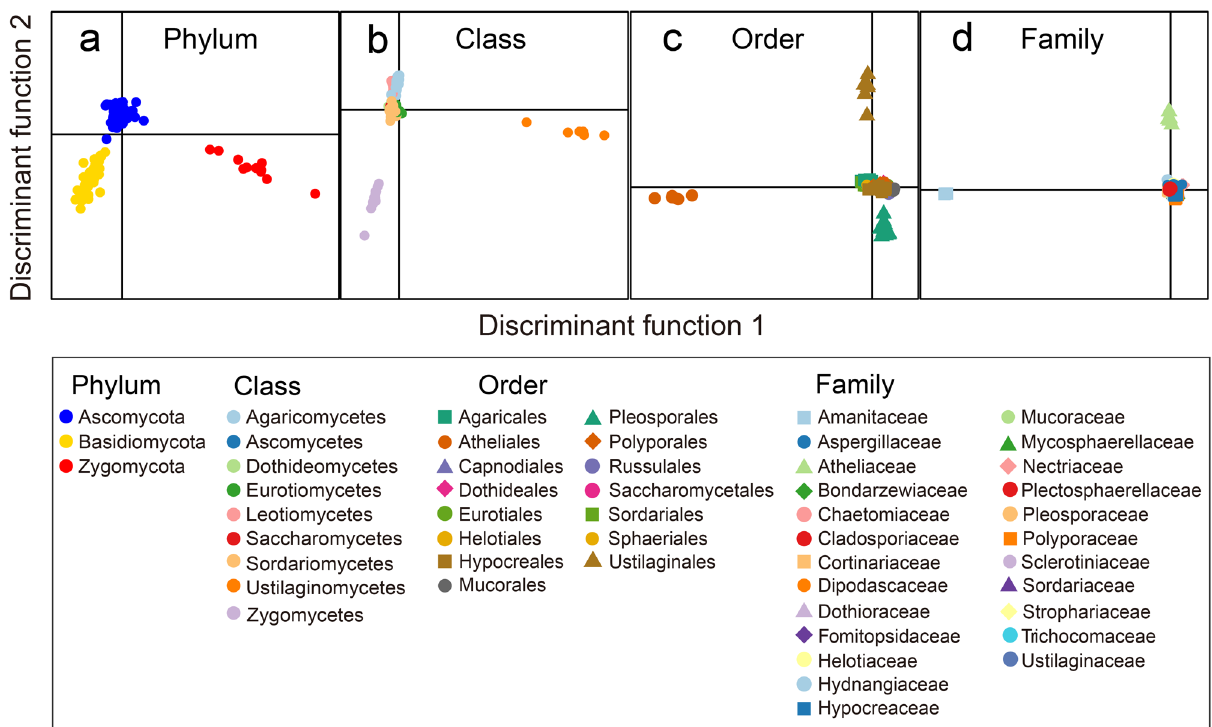
Fig. 3 Chemotaxonomic characterization of different fungal clades. The chemotaxonomic characterization comprises phylum ( a ), class ( b ), order ( c ), and family ( d ) by discriminant analysis of principal components (DAPC) using combined PTR-ToF-MS and GC – MS data. Detailed parametric con fi gurations of DAPC models are provided in the “ Methods ”